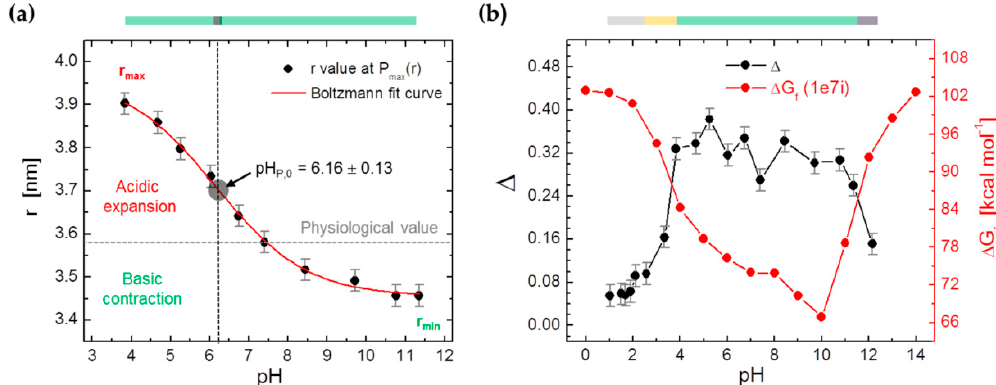
Figure 9. Parameter shifts during pH denaturation of 16 ‐ DSA ‐ probed HSA from DEER data. ( a ) The pH ‐ induced variation of the main distance peaks from P max ( r ) in Figure 8e,f (black) are shown together with a sigmoidal fit curve (red) in the compact form (C) of HSA. Error bars are related to the resolution ( Δ r = 0.025 nm) in corresponding distance distributions. The gray dotted line gives the physiological distance value for pH 7.40 and the black dotted line indicates the midpoint (pH P,0 ) from the sigmoidal fit from Equation (5). The trend in acidic expansion (red) and basic contraction (green) is indicated as proposed in Qiu et al. [53] with r max and r min highlighted. ( b ) The variation in corresponding modulation depths Δ is given as a function of pH (black) together with the stability curve of HSA from Figure 1a (PDB ID: 1e7i). Significant and comparable modulation depths from DEER data are only observed in the compact form (C) of HSA. Error bars for modulation depths Δ are consistently given as suggested in Bode et al. [142] with ΔΔ = 0.02.